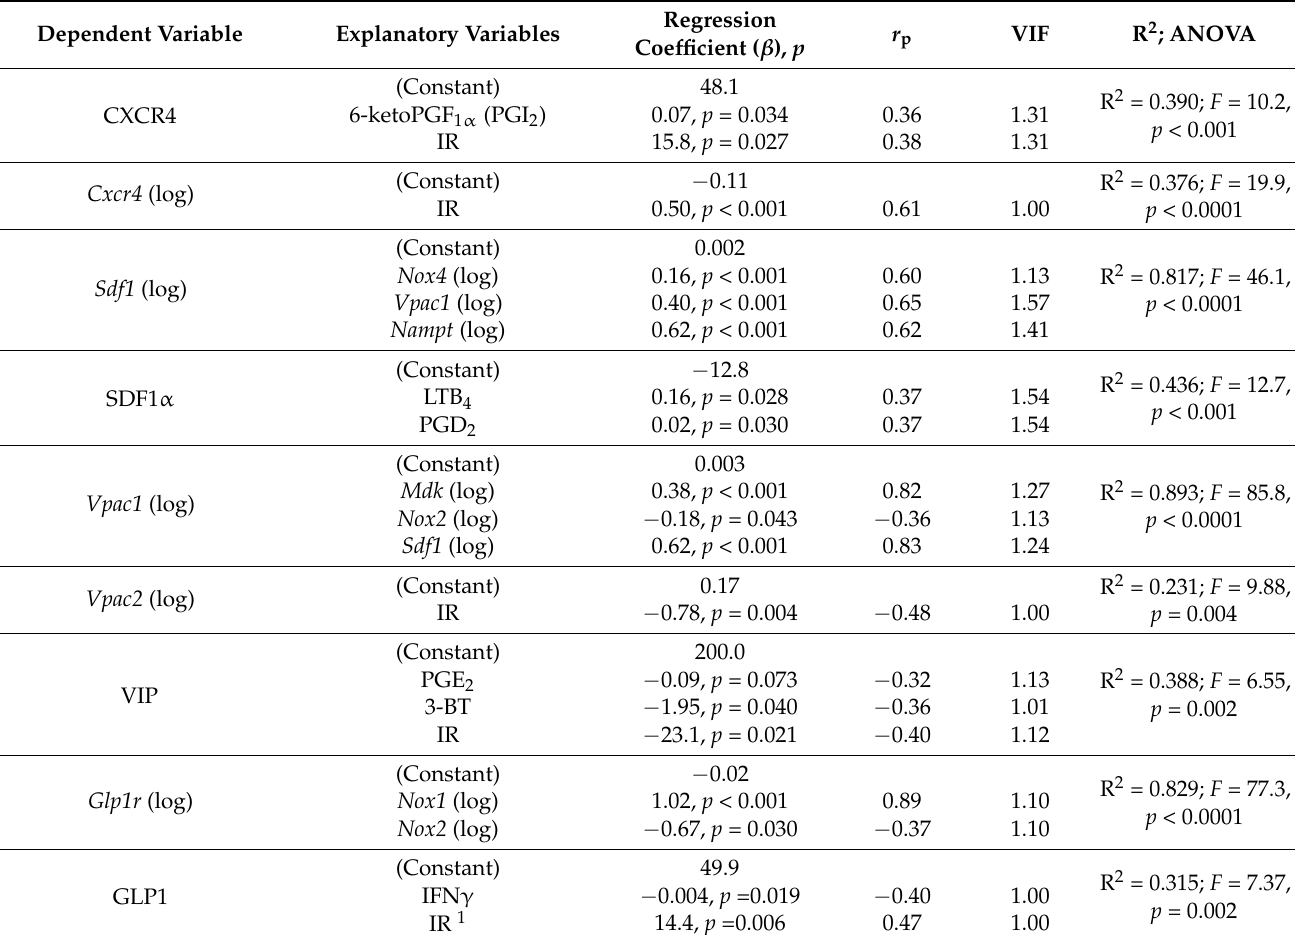
Table 3. Regression models explaining variability in the expression and/or concentrations of DPP4 ligands and their receptors. Dependent